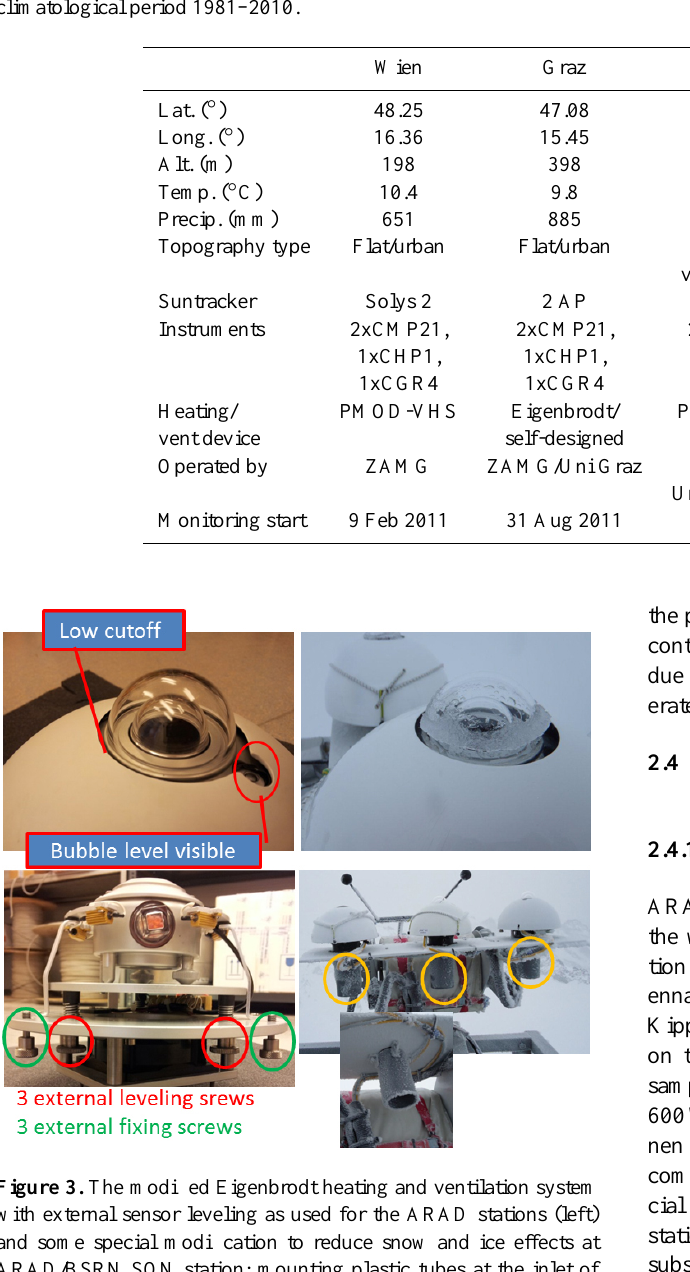
Table 2. List of metadata of the ARAD stations. Mean annual air temperatures (Temp.) and precipitation sums (Precip.) are given for the climatological period 1981–2010.